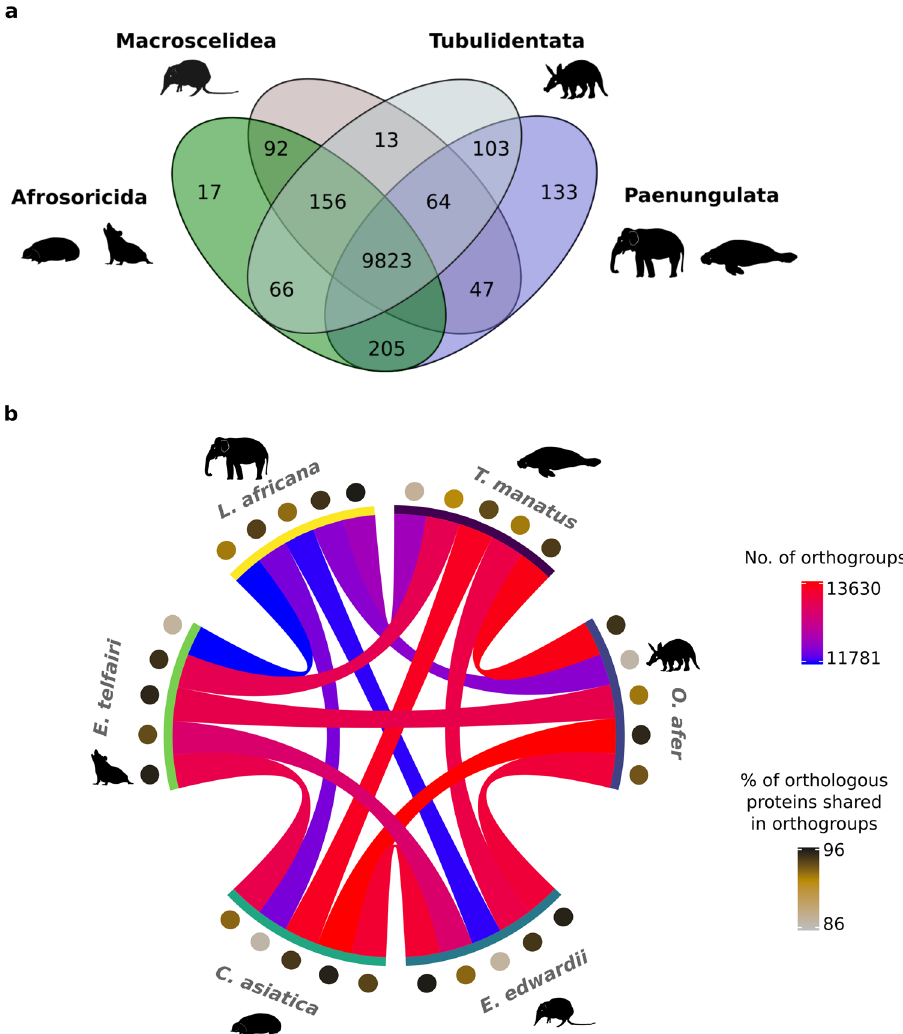
Figure 1. Orthologous relationships within Afrotheria. ( a ) Venn diagram shows the number of orthogroups shared among different orders of Afrotheria. Each order is represented by a different color- green (Afrosoricida), grey (Macroscelidea), blue (Tubulidentata), violet (Paenungulata). ( b ) Chord diagram 50 that represents the total number of orthogroups shared between individual Afrotherian species. The six nodes, represented by a fragment on the outer part of the circular layout, represent each species. Color scale of the arc connecting the nodes between species (blue to red) shows the number of orthogroups between species, that may be low as in C. asiatica and L. africana or high as in C. asiatica and O. afer . Colored circles (grey-dark brown) represent the percentage of orthologous proteins present in the orthogroups between two species. Cartoon drawings of Afrotherian species were prepared using Inkscape 51